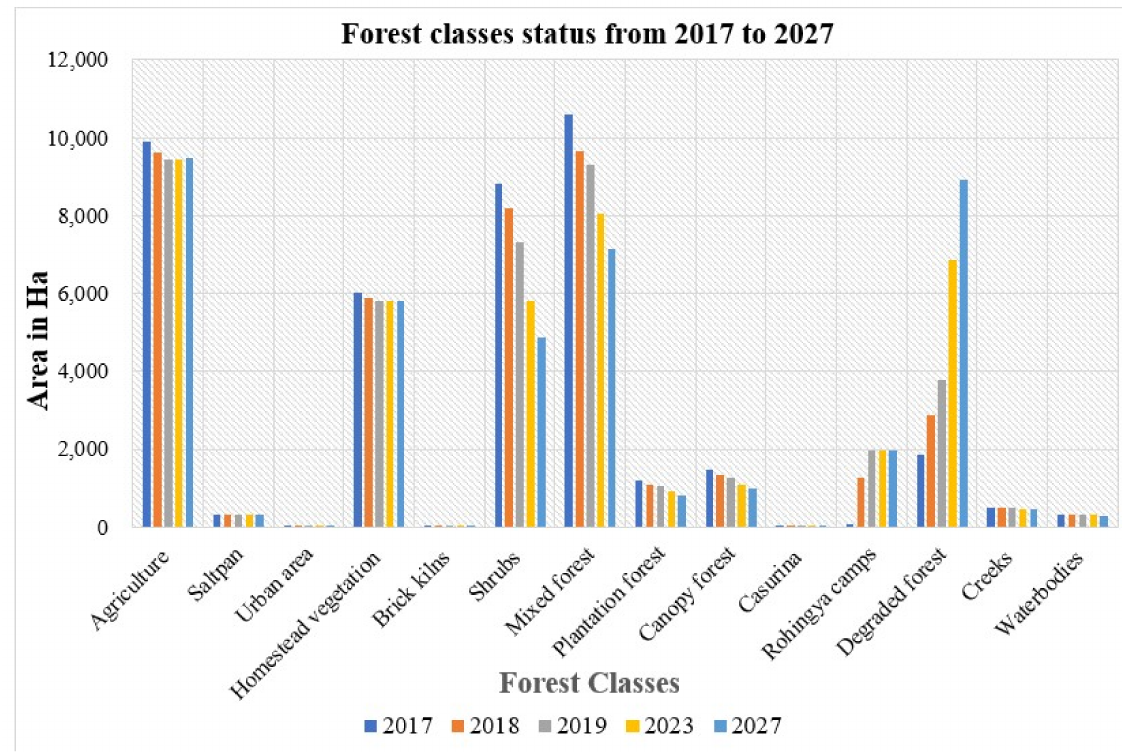
Figure 4. Spatiotemporal forest cover status in Cox’s Bazar–Teknaf peninsula before and after severe anthropogenic stresses caused by the Rohingya